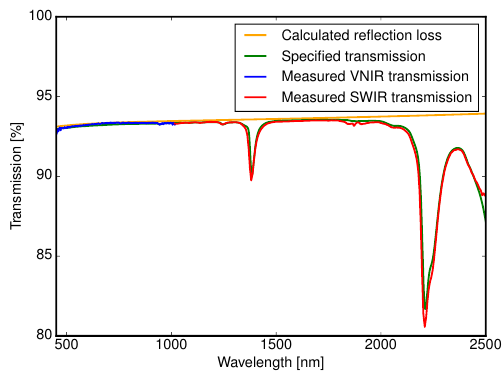
Figure 22. Reflected solar spectra measured with specMACS on- board HALO during the ACRIDICON-CHUVA campaign in